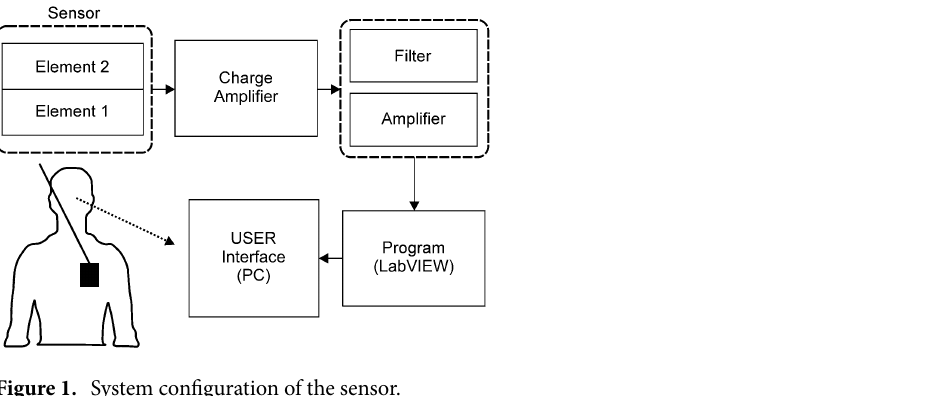
Figure 1. System configuration of the